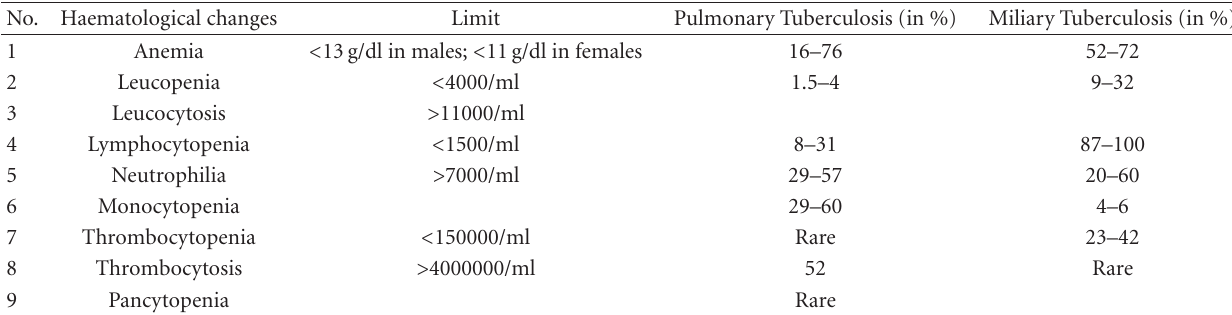
Table 1: Haematological manifestations in patients with tuberculosis in various